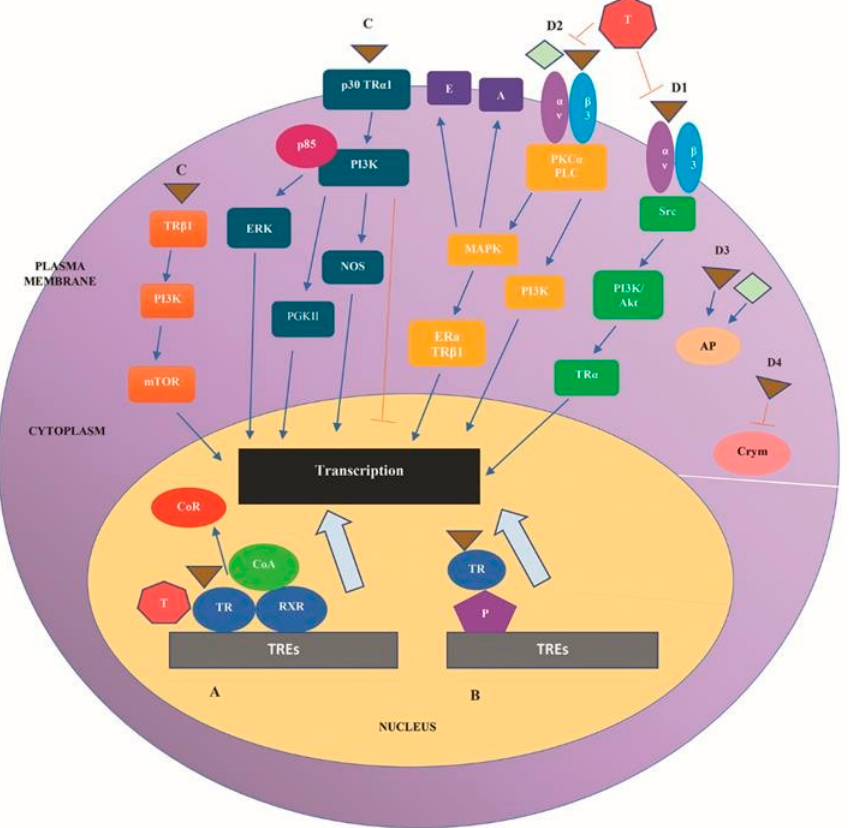
Figure 1. The main signaling cascades implicated in the four types of TH actions. A. Type 1 comprises the nuclear TRs-dependent TH actions, induced by recruitment of TRs to TREs. Binding of T3 (represented by the brown triangle) to TRs results in dissociation of CoR from the TR/RXR hetero-dimers and recruitment of CoA, inducing target gene transcription. B. Type 2 comprises the TRs-dependent actions of TH exerted through tethering to other chromatin proteins binding of T3-bound TRs to DNA. C. Type 3 TH actions comprises the nuclear TRs-independent TH actions exerted through direct or indirect binding to DNA. Especially, interaction of T3 with cytoplasmic TRs or with the truncated TR α isoforms p30 TR α 1 at the plasma membrane stimulates signaling transduction that results in promotion of transcription; D. Type 4 comprises various nuclear TRs-independent TH actions as follows. D1. Binding of T3 to integrin α v β 3 activates the Src/PI3K/Akt pathway, leading to the shuttling of cytoplasmic TR α to the nucleus, promoting transcription. D2. Binding of T4 (represented by the green rhombus) and of T3 to integrin α v β 3 activates PI3K/Akt and MAPK)/ERK1/2 pathways via PLCP and KC α . Activated MAPK induces the sodium proton ex-changer (Na + /H + ), increases activity of the sodium pump (Na, K-ATPase), and modulates intracellular protein trafficking of proteins, such as ER α and TR β 1, from the cytoplasm to nucleus, promoting the transcription. Activated PI3K transduces also signaling that promotes transcription. D3. Type 4 includes also the TH actions on polymerization of actin. D4. Type 4 includes the action of T3 as regulator of Crym. Abbreviations: A, sodium pump Na, K-ATPase; Akt/protein kinase B (PKB); AP, actin polymerization; CoA, coactivators; CoR, corepressors E, sodium proton exchanger (Na + /H + ); ERK, extracellular signal-regulated kinase; P, proteins; PI3K, PKC α , protein kinase C α ; PLC, phospholipase C; PKGII, type II cGMP-dependent protein kinase; MAPK, mitogen-activated protein kinase; mTOR, mammalian target of rapamycin; NOS nitric oxide synthase; NP, nucleoproteins; RXR, retinoic acid X receptor; TR, thyroid hormone receptor; TR α 1, TRalpha isoform 1; TR β 1, TRbeta isoform 1; TREs, thyroid response elements.